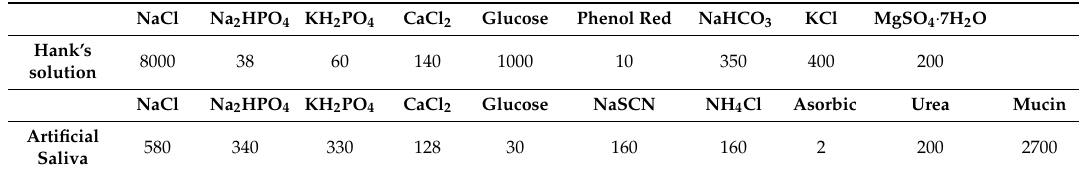
Table 1. Content of artificial saliva and Hank’s solution in mg /